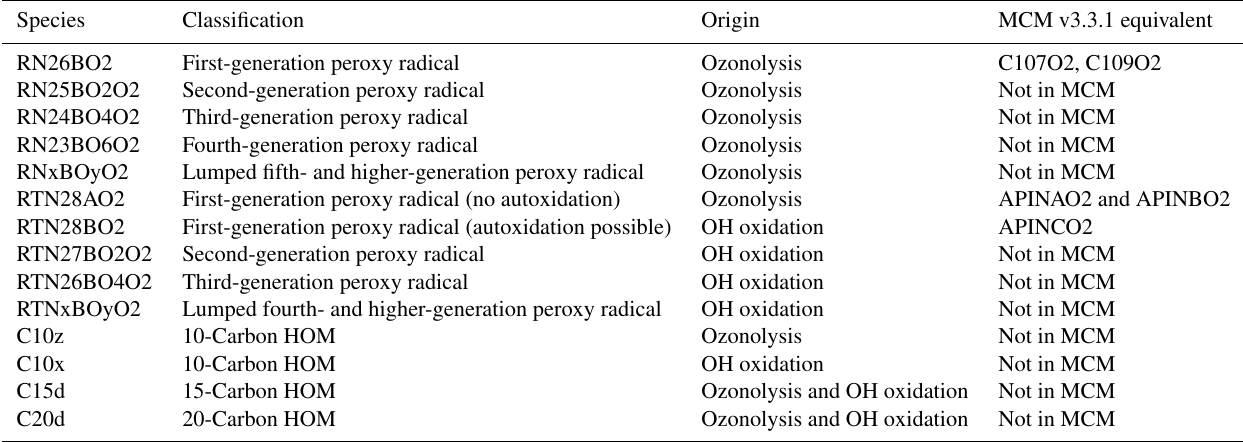
Table 1. Summary of new species added in HOM mechanism. The removal of species RN18AO2 and RTN28O2 results in a net increase of 12 species.